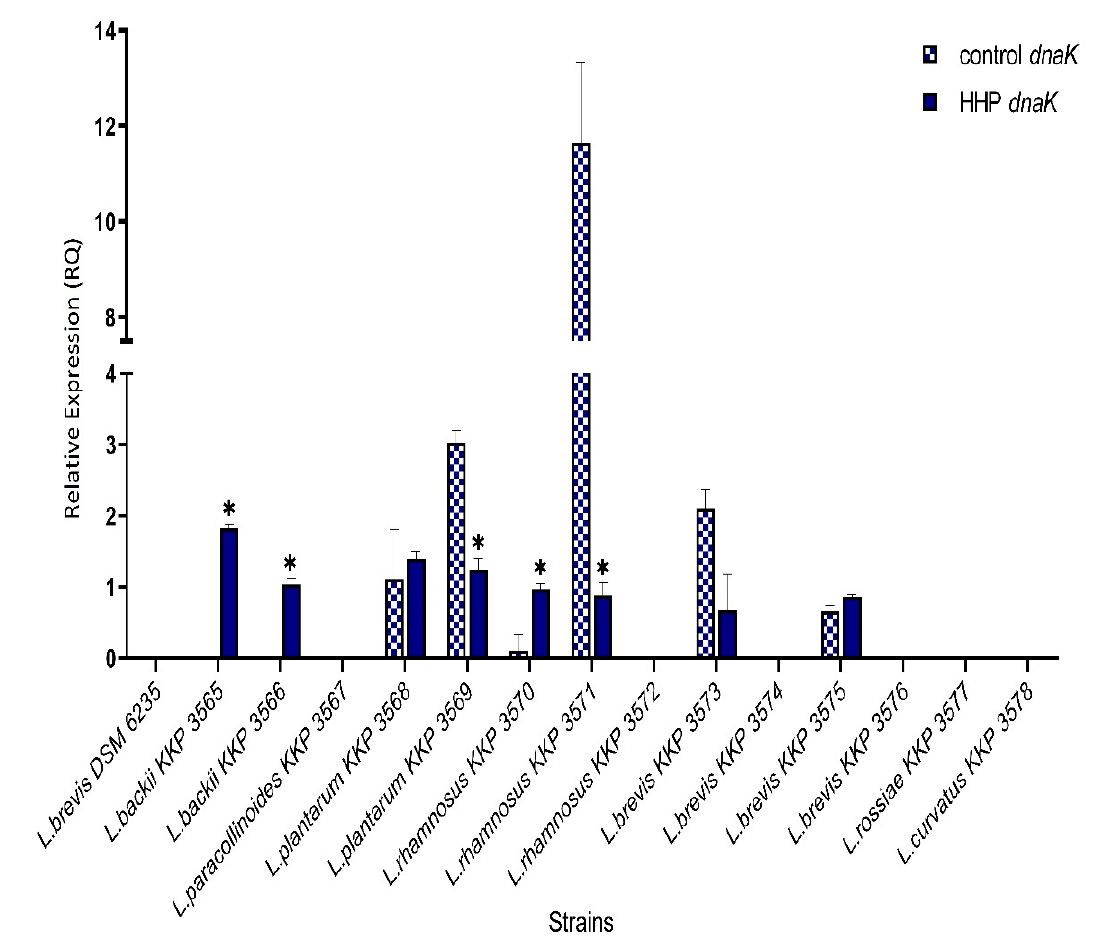
Figure 2. Relative gene expression of dnaK in LAB strains before and after exposure to 300 MPa pressure for 5 min. determined by RT-qPCR analysis. Presented data are the mean of the two independent experiments and the standard deviations are indicated with vertical bars. * Statistically significant differences were determined by Student’s t -test ( p < 0.05).